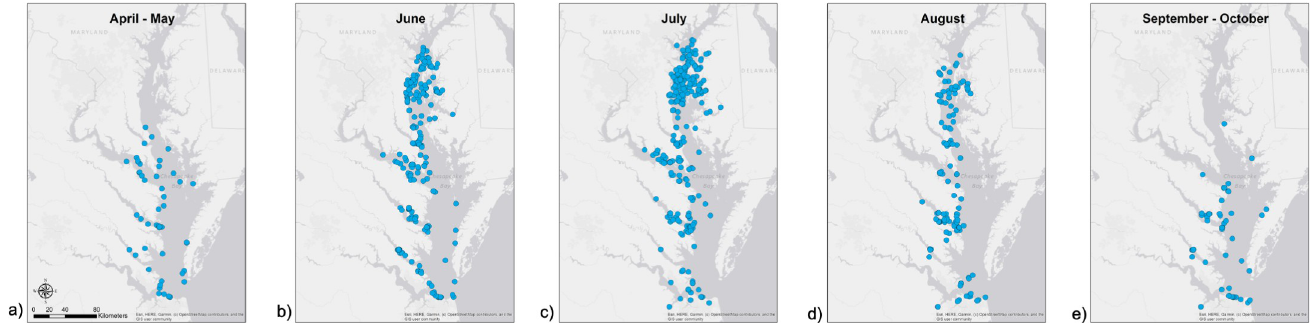
Fig 4. Spatial distribution of confirmed, non-replicated bottlenose dolphin sighting reports from Chesapeake DolphinWatch for 2018.